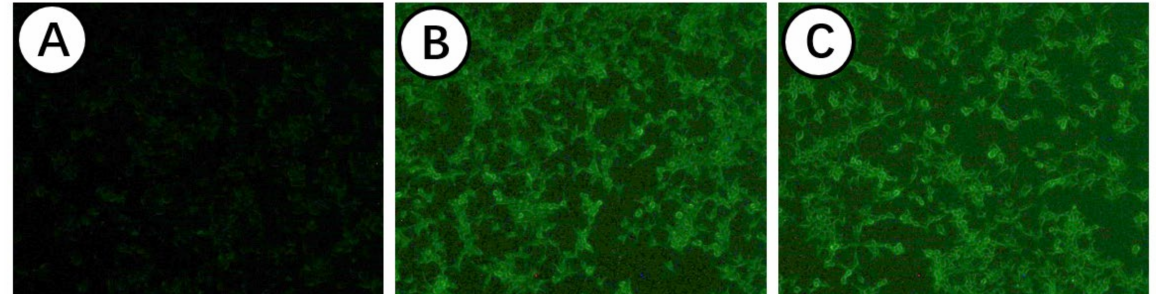
Figure 3. Expression of IHNV-G protein of DNA vaccine in 293T cells by IFA. Recombinant DNA vaccine plasmids were transiently transfected into 293T cells, and the expression of IHNV-G protein was detected by IFA. ( A ) Nontransfected cells. ( B ) Cells transfected with pcDNA-BjLL. ( C ) Cells transfected with